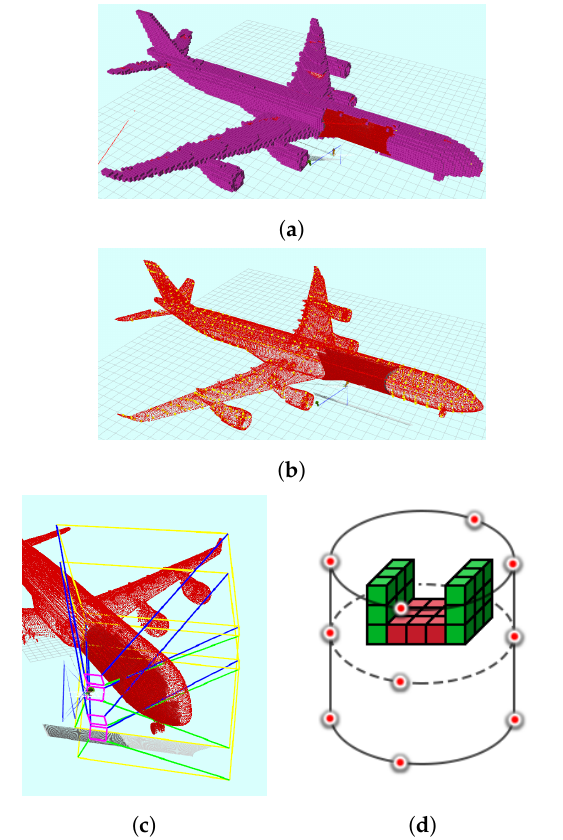
Figure 6. ( a ) Low density frontier voxels shown in purple; ( b ) the centroids (yellow) of the clusters of the frontiers voxels; ( c ) FOV planes visualization where two sensors are mounted on the UAV; and ( d ) an example of the three layers to cover an example frontier voxels (cubes)